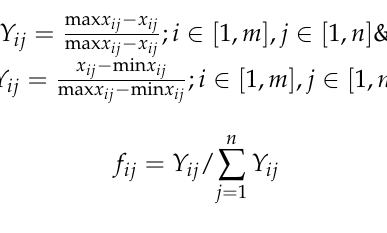
Figure 3. Experimental scene and data monitoring interface. Source: ErgoLAB platform experiment export.